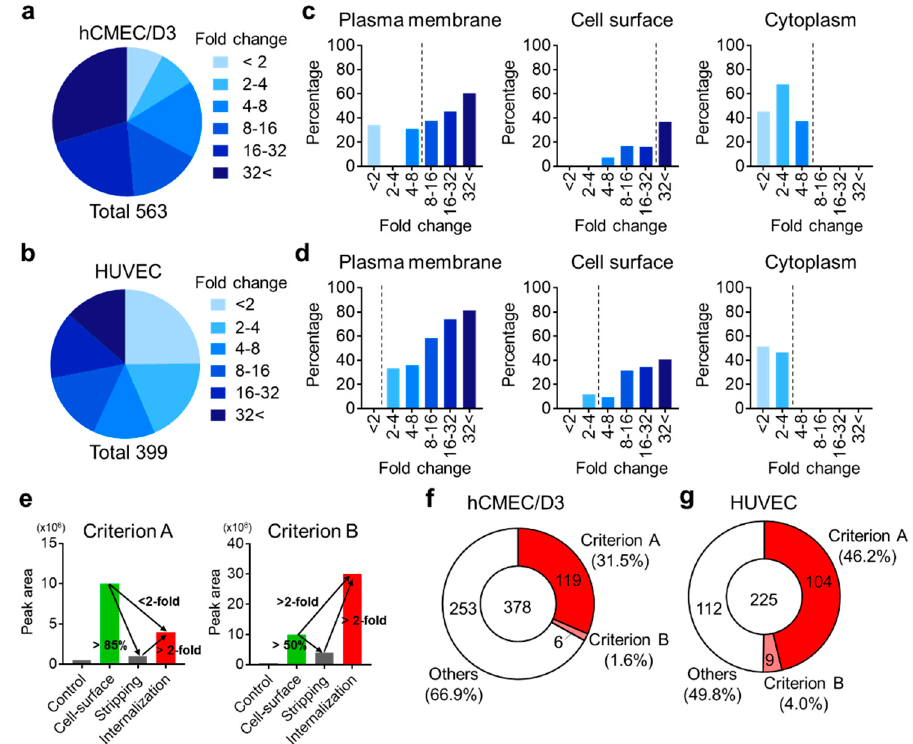
Figure 3. Identification of “biotinylated cell-surface proteins” and “biotinylated endocytic cell-surface proteins” in hCMEC/D3 cells and HUVECs. ( a , b ) “Cell-surface”-to-“Control” peak area ratio of all identified proteins in hCMEC/D3 cells ( a ) and HUVECs ( b ) were calculated, and the “Cell-surface”-to-“Control” peak area ratios of all identified proteins were grouped on a binary logarithmic scale. ( c , d ) The percentage of identified proteins annotated with “Plasma membrane”, “Cell surface”, or “Cytoplasm” in each group in hCMEC/D3 cells ( c ), and HUVECs ( d ) was calculated and grouped on a binary logarithmic scale. The threshold determined as indicating plasma membrane proteins was a “Cell-surface”-to-“Control” peak area ratio of 8 and 4, respectively, in hCMEC/D3 cells and HUVECs. ( e ) Scheme of criteria for the extraction of “biotinylated endocytic cell-surface proteins” in the cells (Criterion A and B). ( f , g ) Numbers of identified “biotinylated endocytic cell-surface proteins” in hCMEC/D3 cells ( f ) and HUVECs ( g ).